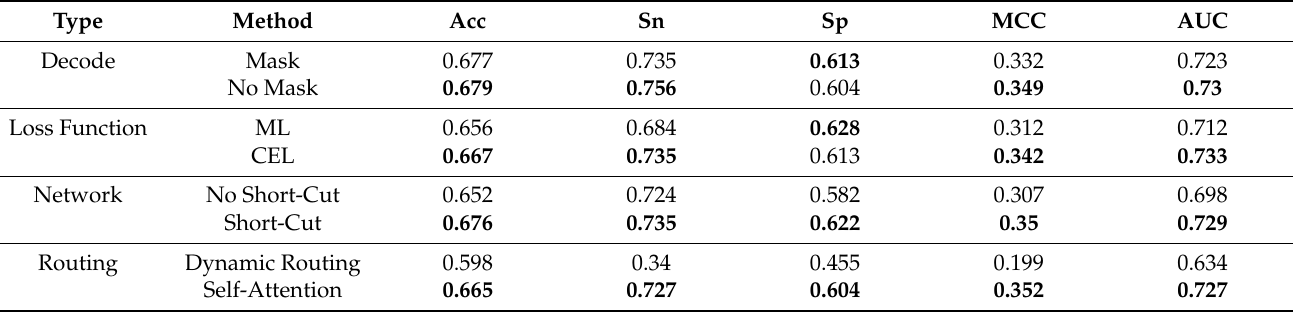
Table 2. Prediction results of ablation